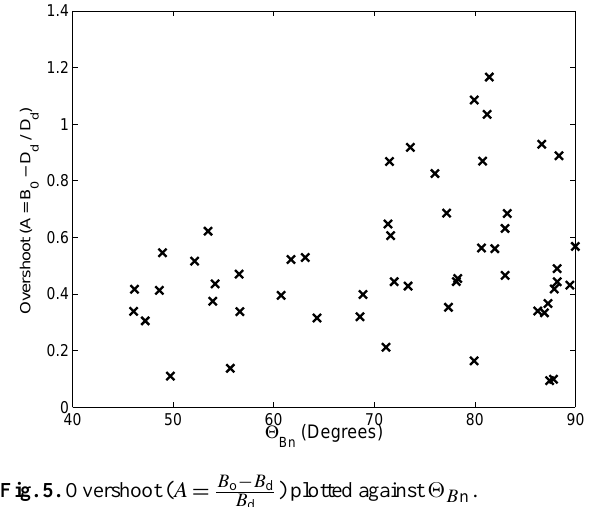
− B d ) plotted against 2 B n B d